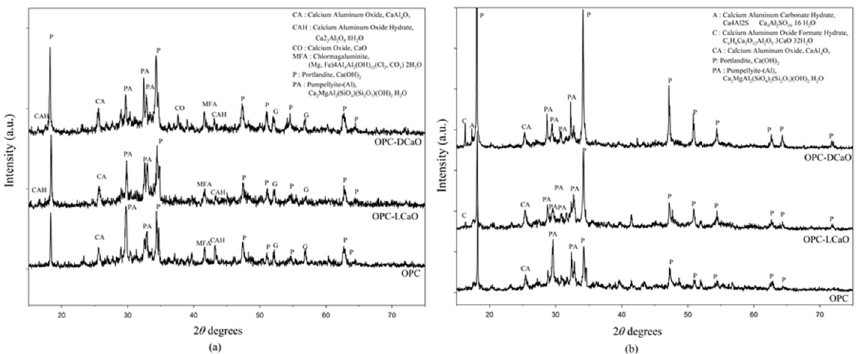
Figure 4. XRD patterns of OPC, OPC-LCaO and OPC-DCaO ( a ) before and ( b ) after the autoclave expansion test. expansion